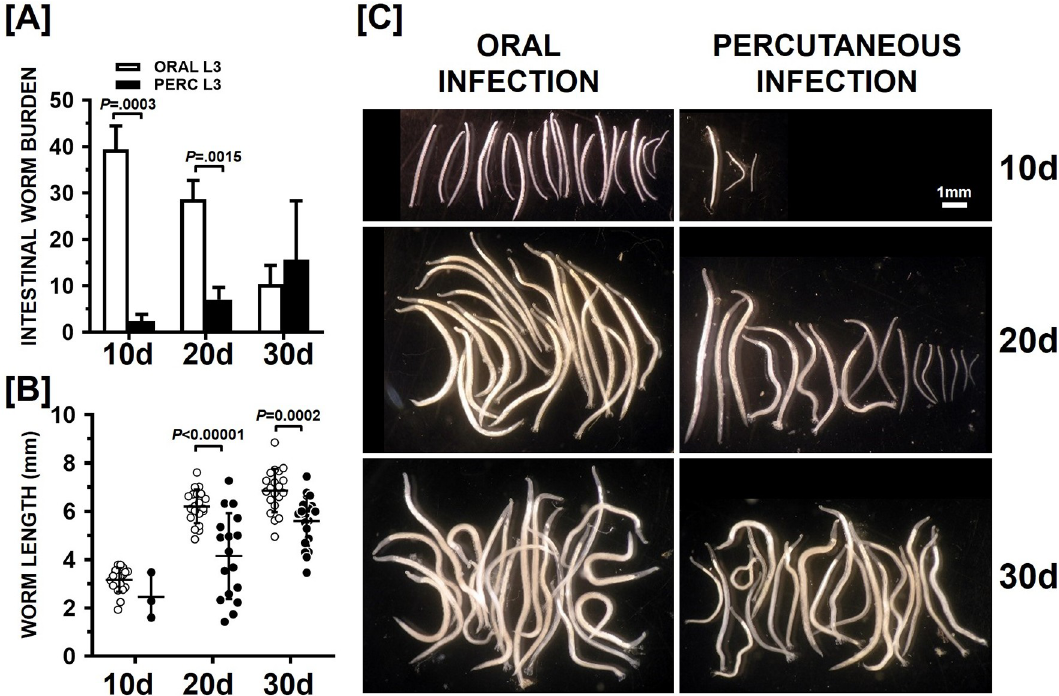
Fig 3. Intestinal worm burden and worm lengths following percutaneous infection (Experiment 2). Hamsters (n = 9 each group) were infected with 100 L3 by the oral route or 2000 L3 by the percutaneous (PERC) route. At days indicated, three animals from each group were sacrificed and intestinal worms recovered, counted and measured. Mean +/- SD intestinal worm burdens at each time point are shown in [A], worm length at each time point in [B] and representative photographs of worms recovered at each time point in [C]. In [A] and [B] brackets indicate statistically significant comparisons by Welch t test, with P values given above the brackets.